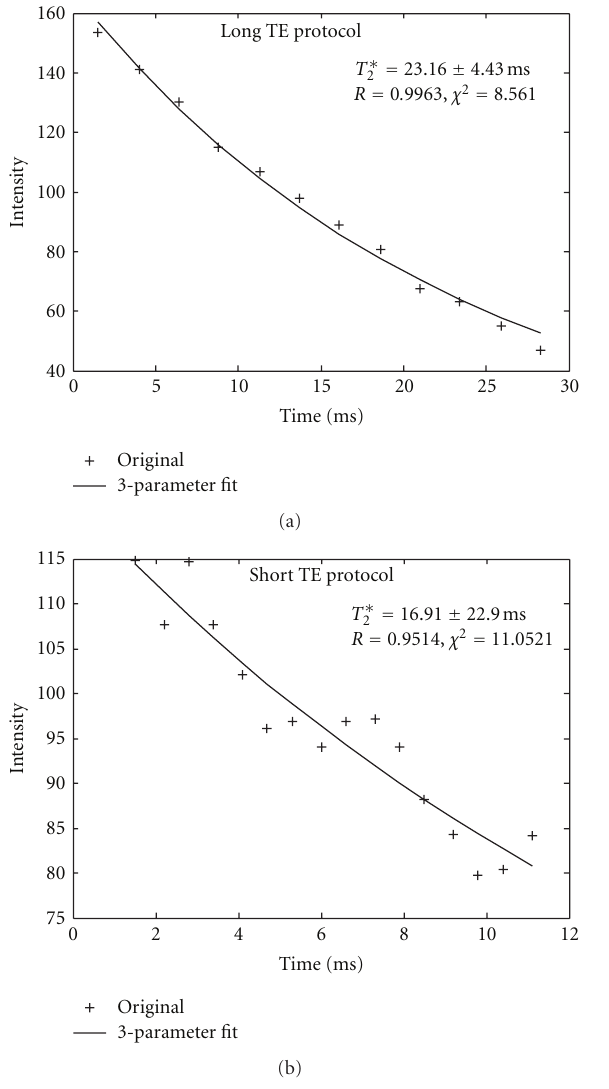
Figure 1: Results of T ∗ 2 curve fit from a patient with long T ∗ 2 values by dual acquisition method. (a). Data was acquired by the long TE protocol. (b) the same patient data was acquired by the short TE protocol. It is obvious for this case that the T ∗ 2 fit error is increasing with shorter TE coverage. The long TE data acquisition is necessary for mild iron load patient.